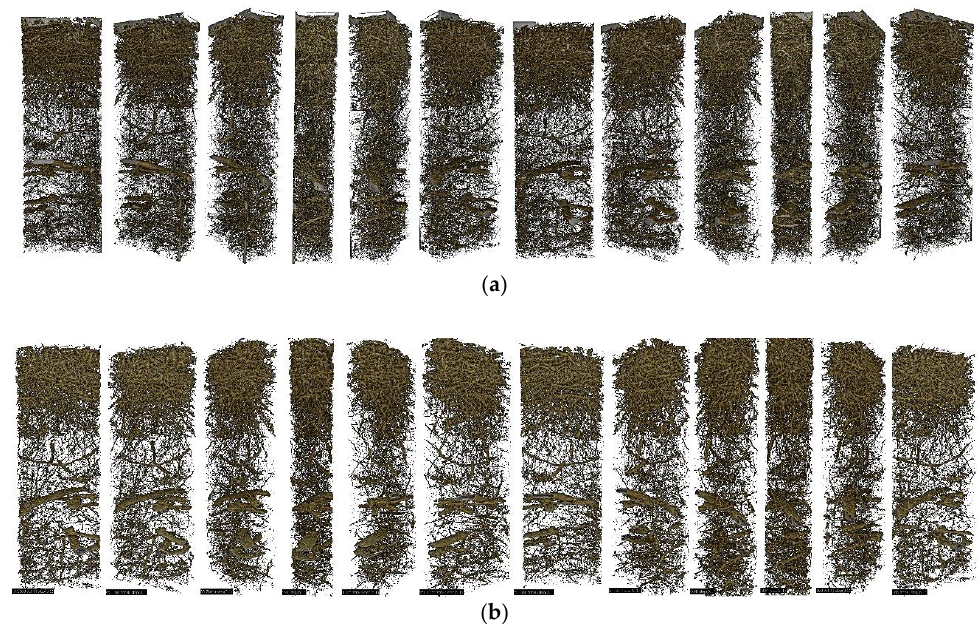
Figure 6. Image series of 3D model for RWSS rotating clockwise. ( a ) Unfiltered and with ice on top, ( b ) with size filter and ice removed. The size of the monolith is 6.1 cm × 12.5 cm × 36.6 cm.